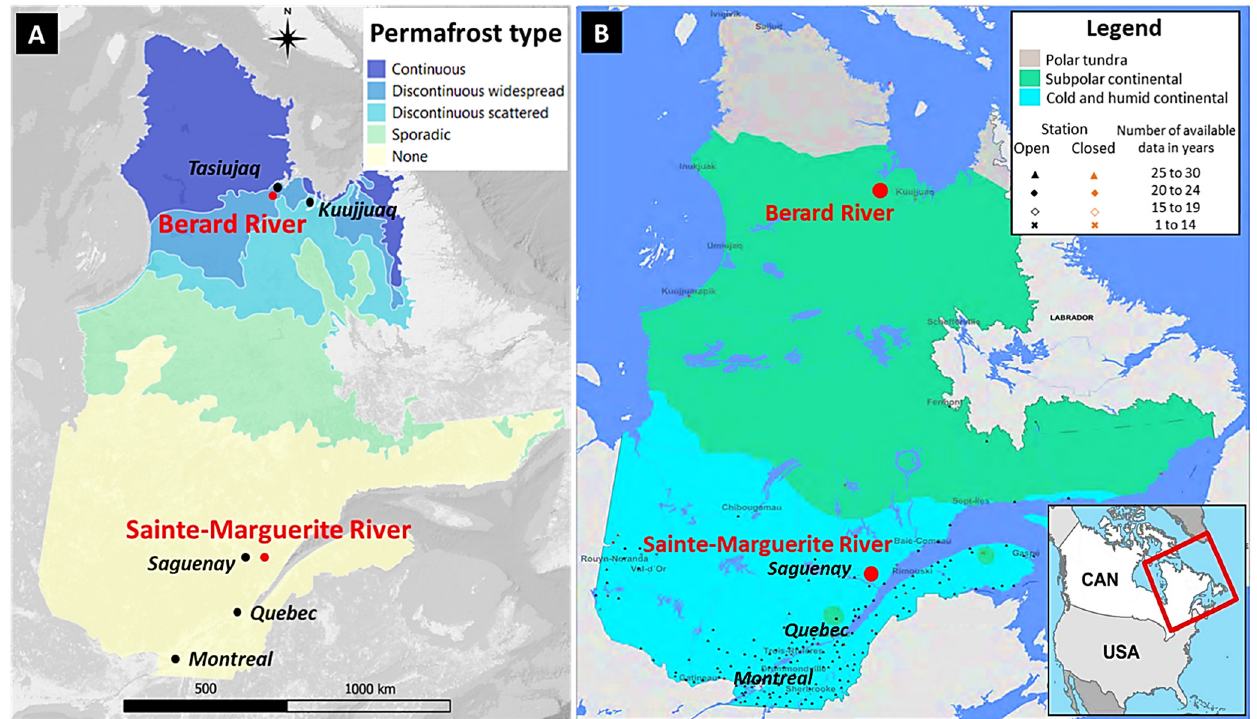
Figure 1. Location of the two studied rivers on permafrost distribution map (( A ) adapted from [34]) and Köppen climate classification map (( B ) [35]) of the Quebec Province.